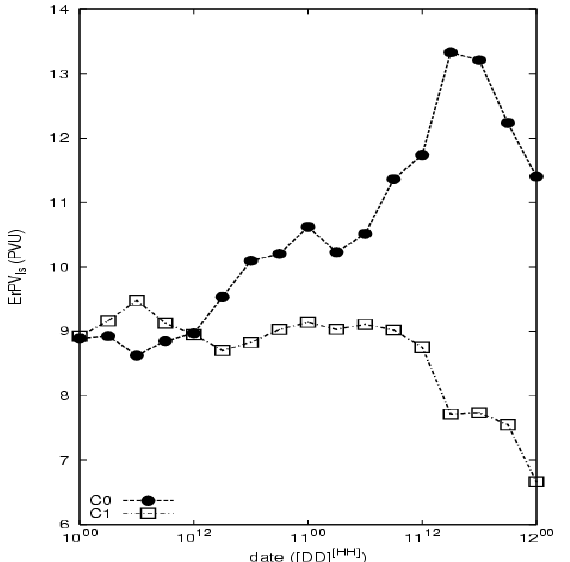
Fig. 4. Simulated central value (PVU) of the two upper level vor- tices C0 and C1, that are embedded within the upper level